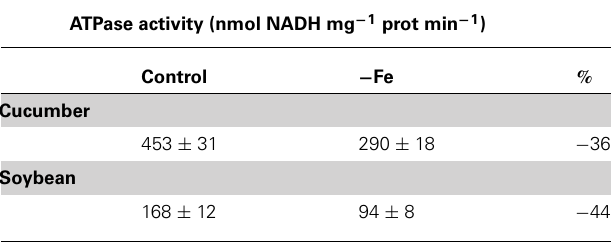
Table 1 | Nitrate-sensitive H + -ATPase activity determined on tonoplast enriched fractions isolated from roots of 8-day-old cucumber and 11-day-old soybean plants grown in the presence (control) and in the absence of iron ( −